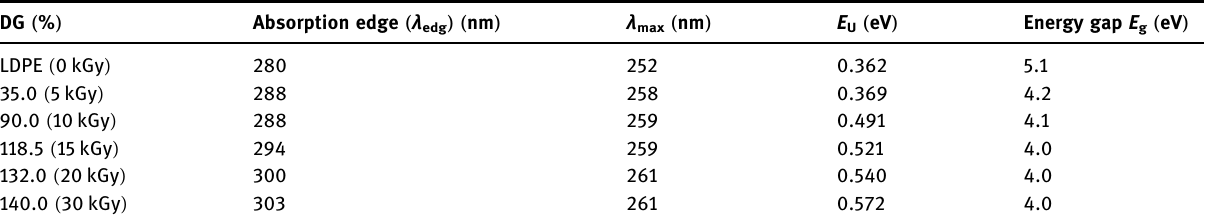
Table 2: UV - Vis parameters; absorption edge, absorption maximum, Urbach energy and optical energy band gap of ungrafted and grafted LDPE DG ( %